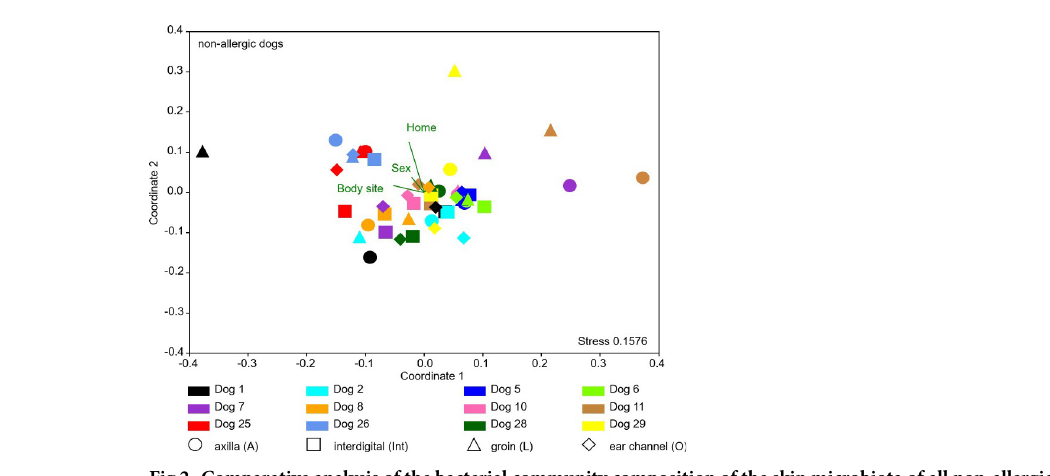
Fig 2. Comparative analysis of the bacterial community composition of the skin microbiota of all non-allergic dogs. Comparative analysis of the relative abundance patterns of the skin microbiota composition of all body sites (different objects), performed by NMDS analysis based on a Bray-Curtis similarity matrix. Sex, body site, and home were included as environmental parameters (biplots). Different colors represent individual dogs.